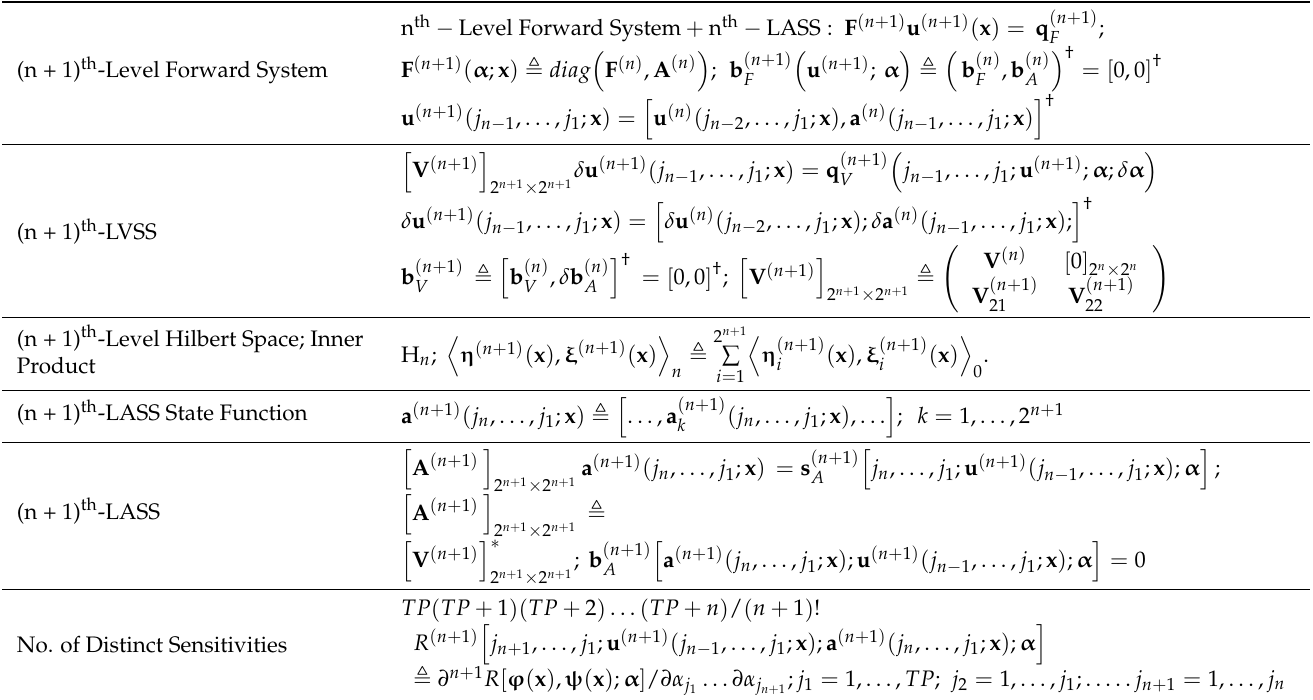
Table 6. (n + 1) th -Order